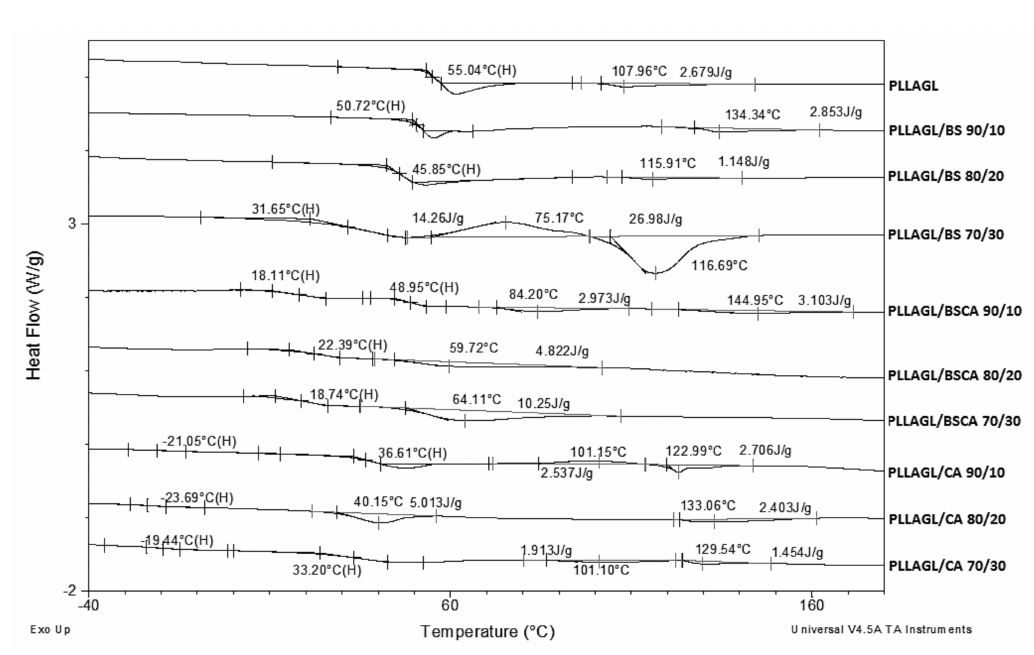
Figure 2. DSC thermograms (I run, heating rate of 20 ◦ C /